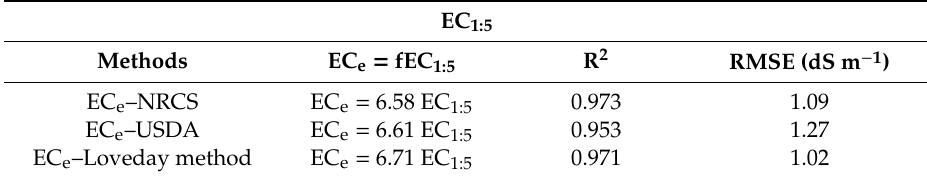
Table 4. Regression equations describing the relation between saturated paste extracts EC e and EC 1:5 determined by three di ff erent methods with the coe ffi cients of determination (R 2 ) and root mean square errors (RMSE) for all soil samples examined.